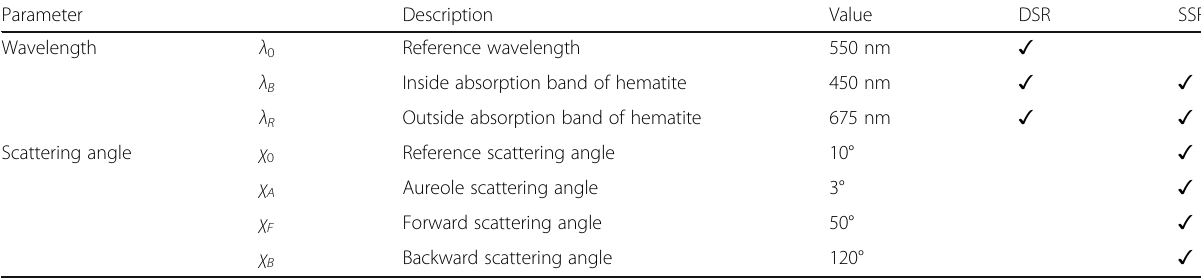
Table 3 Wavelengths and scattering angles chosen for dust observation Parameter